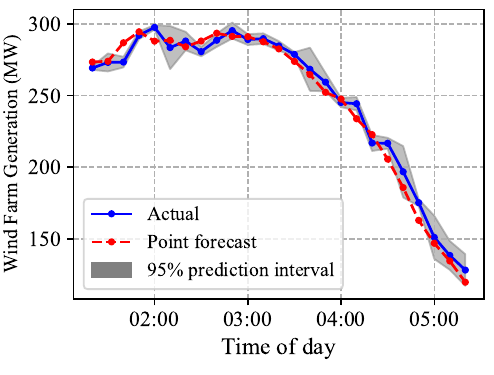
Figure 12. On 9 October